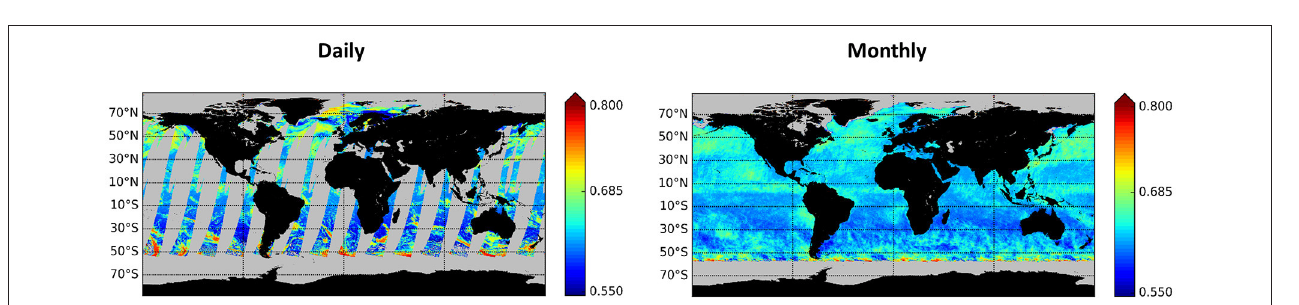
FIGURE 16 | Same as Figure 15 but for the average cosine below the surface.